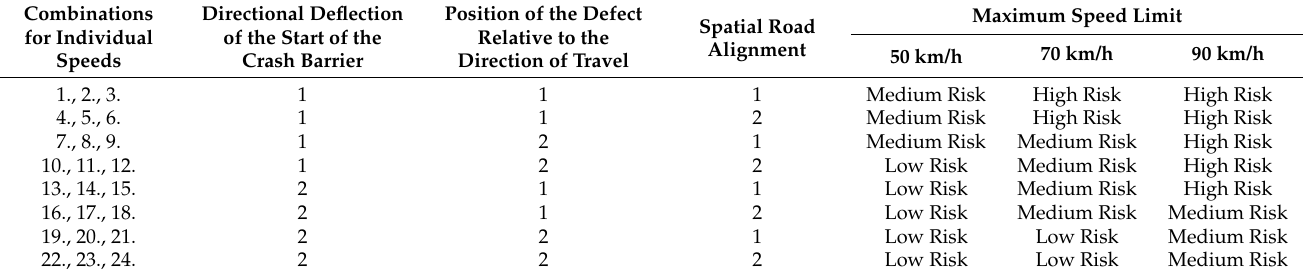
Table 5. Predicted risk level of individual exposures for defect—Incorrect beginning/end of the crash barrier.